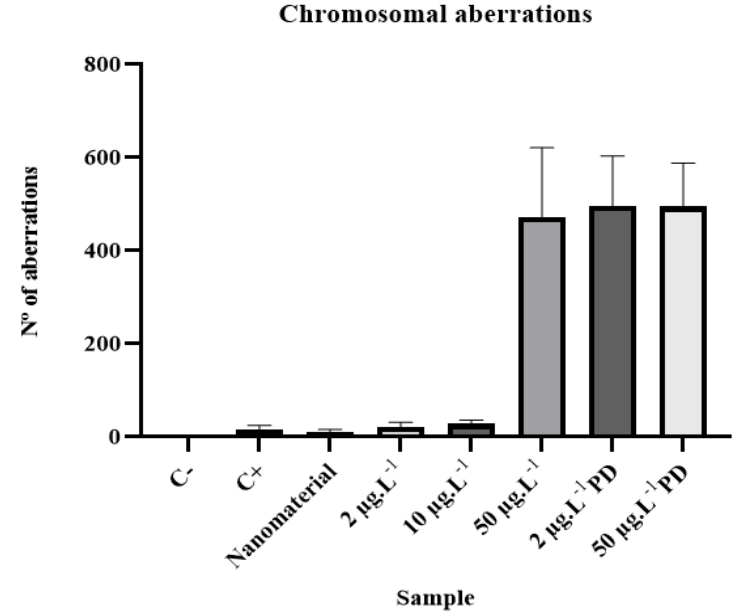
Figure 6. Mean values and standard deviations for chromosomal aberrations of analyzed samples.